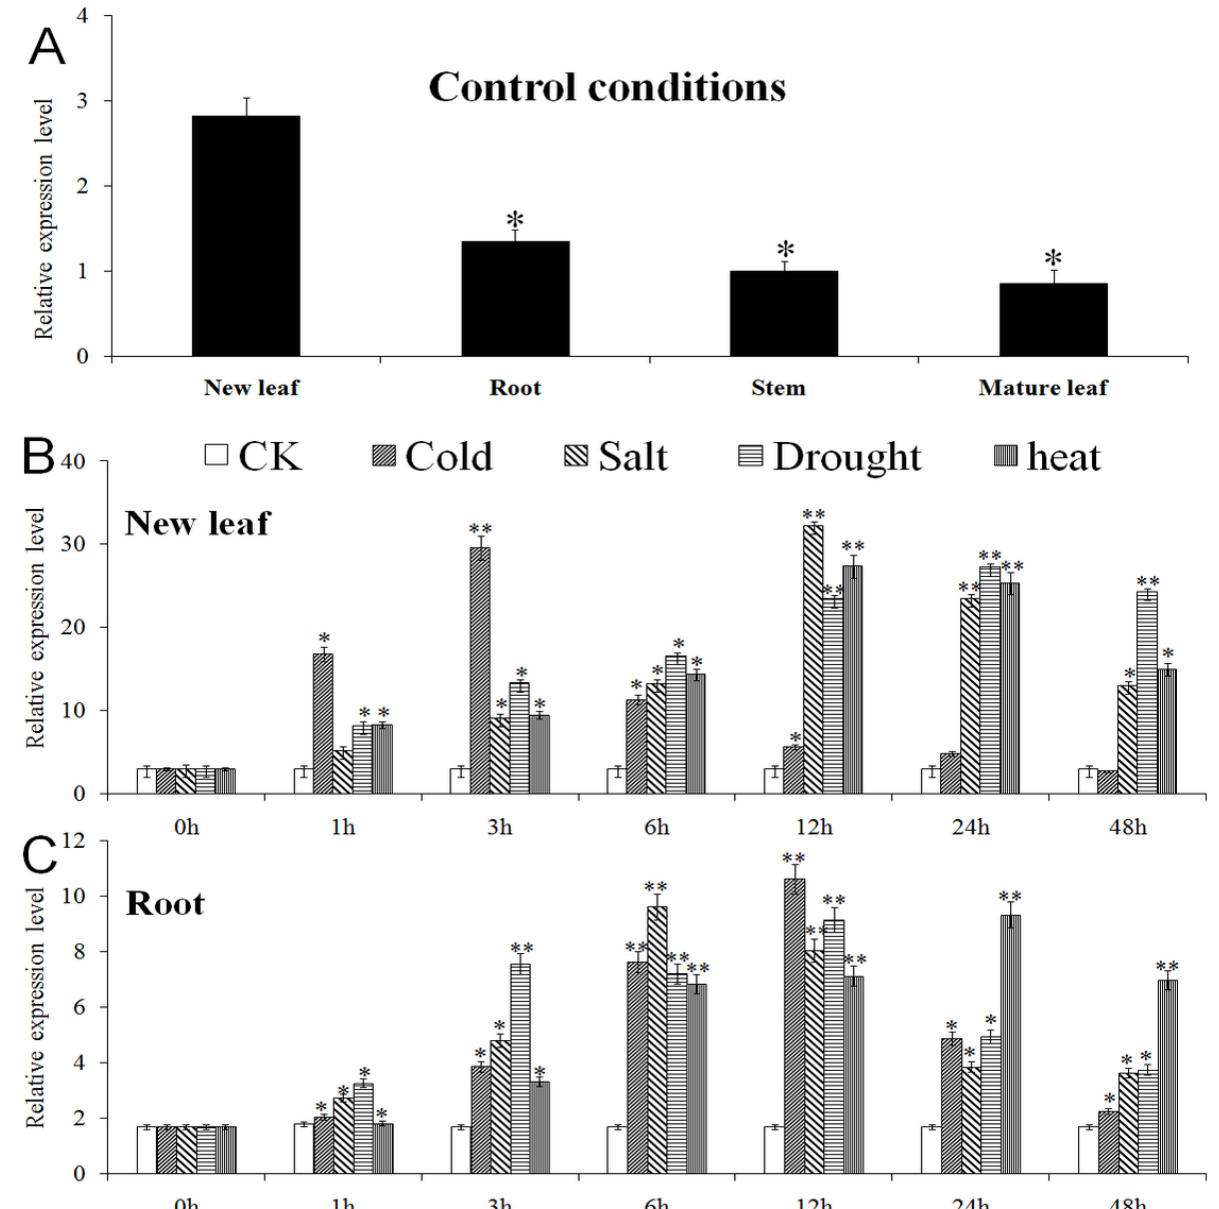
Figure 3. qRT-PCR results of the VvWRKY28 gene. ( A ) Under normal conditions, VvWRKY28 was expressed in new leaves, roots, stems, and mature leaves of grapes. The expression level in the new leaves was the control. ( B , C ) expression levels of VvWRKY28 in new leaves and roots at multiple points in time (0, 1, 3, 6, 12, 24, and 48 h) under normal conditions, low temperature, salt, drought, and heat stress. The data were the average of 3 repeated trials. The asterisk above the column indicated that there were significant and extremely significant differences between the treatment group and the control group (control) (* p ≤ 0.05; ** p ≤ 0.01).